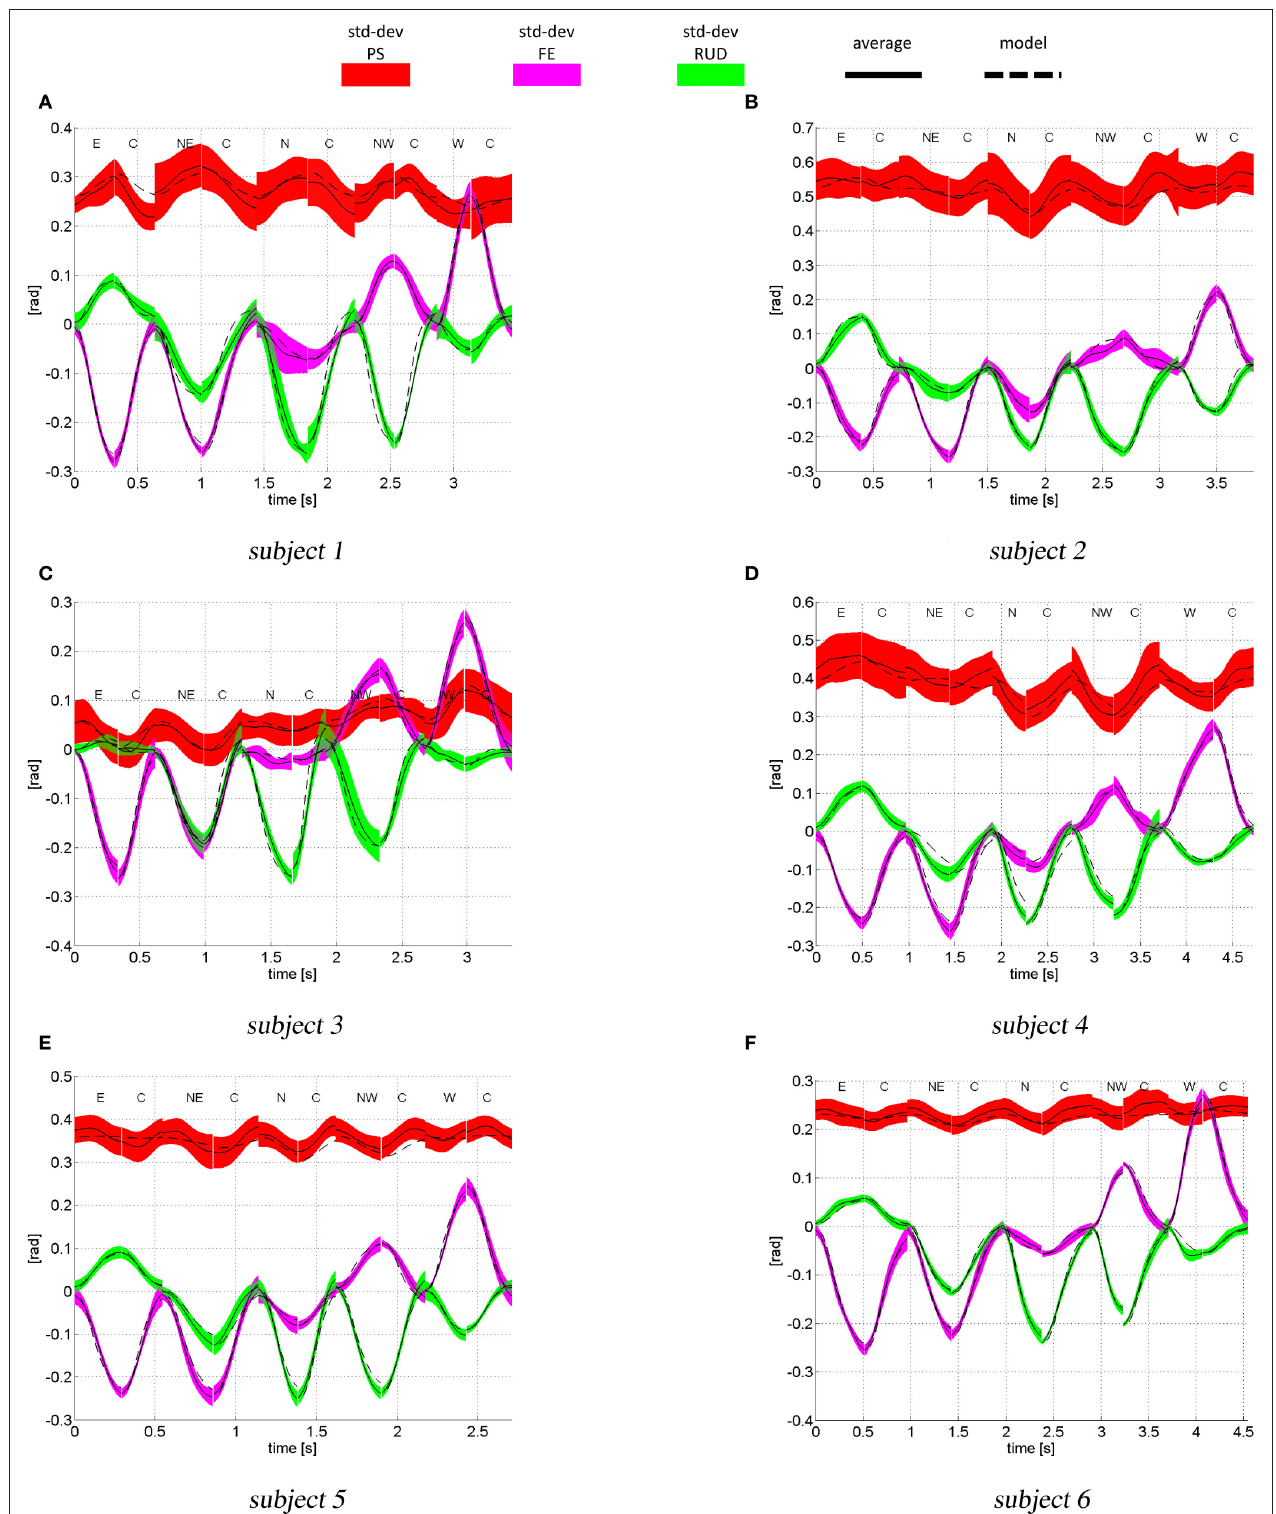
FIGURE 7 | Joint space trajectories (PS in red, FE in magenta and RUD in green), predicted by the model (dashed lines) and measured experimentally: mean (continuous line) and standard deviations (color areas). The letters indicate the target sequence. For instance, the first movement is an outbound movement toward the target (E), the second movement is an inbound movement from target (E) to target (C) and so forth.